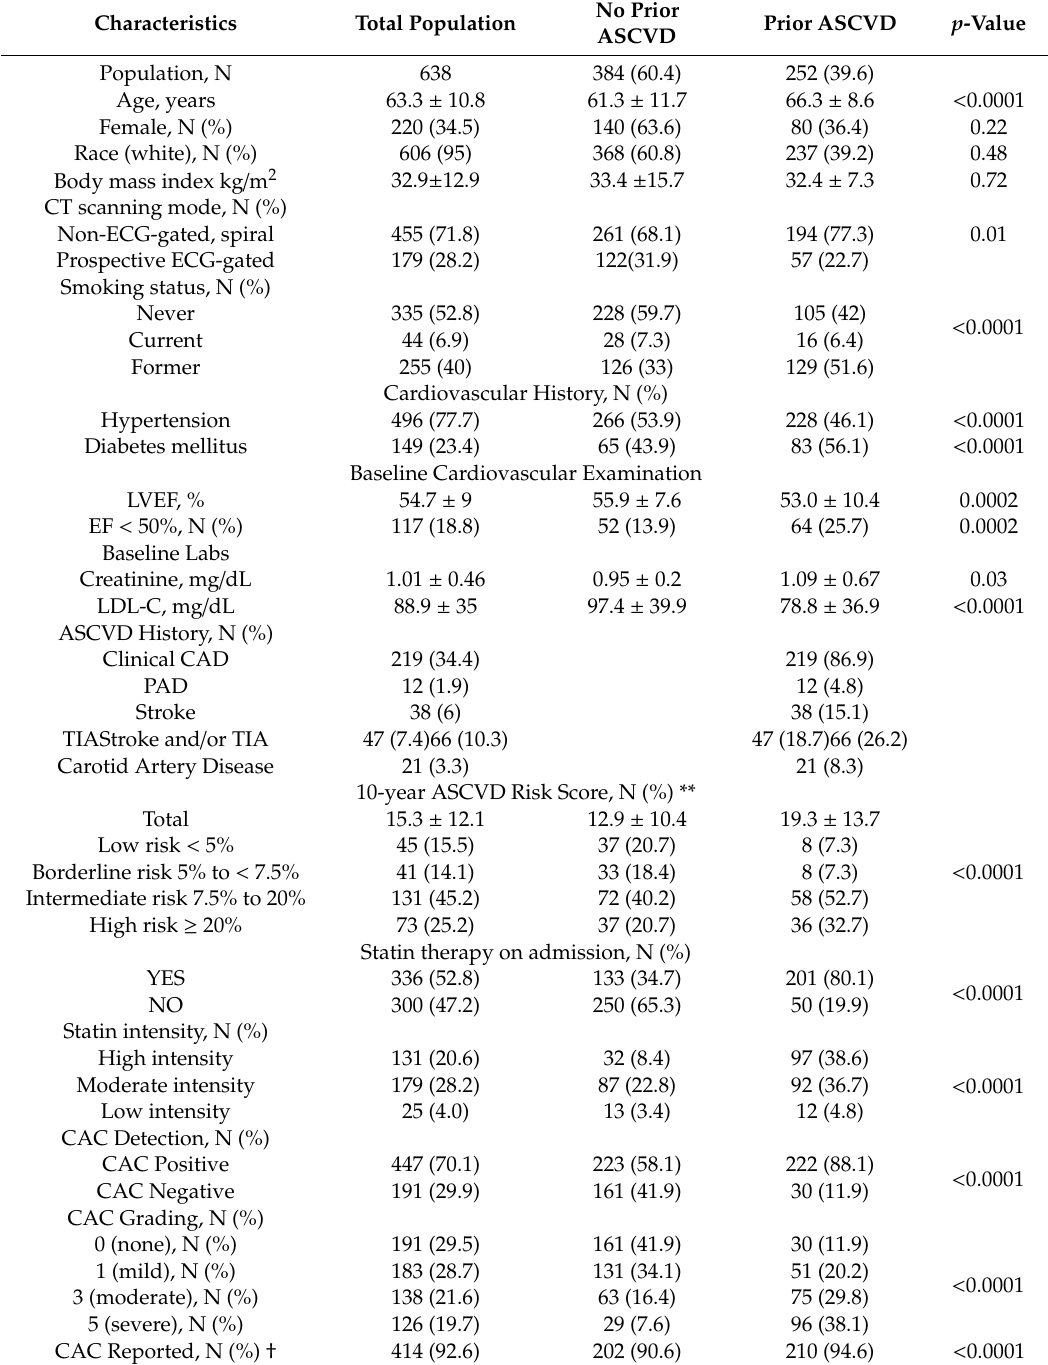
Table 1. Demographic and clinical characteristics of the study population